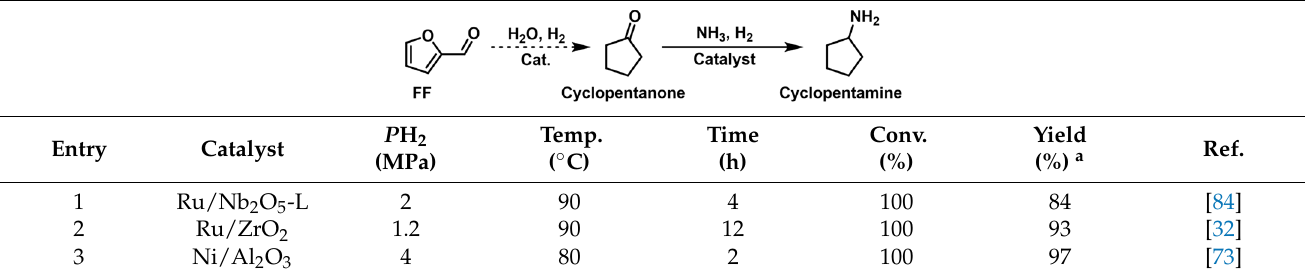
Table 4. The reductive amination of FF-derived cyclopentanone with NH 3 .